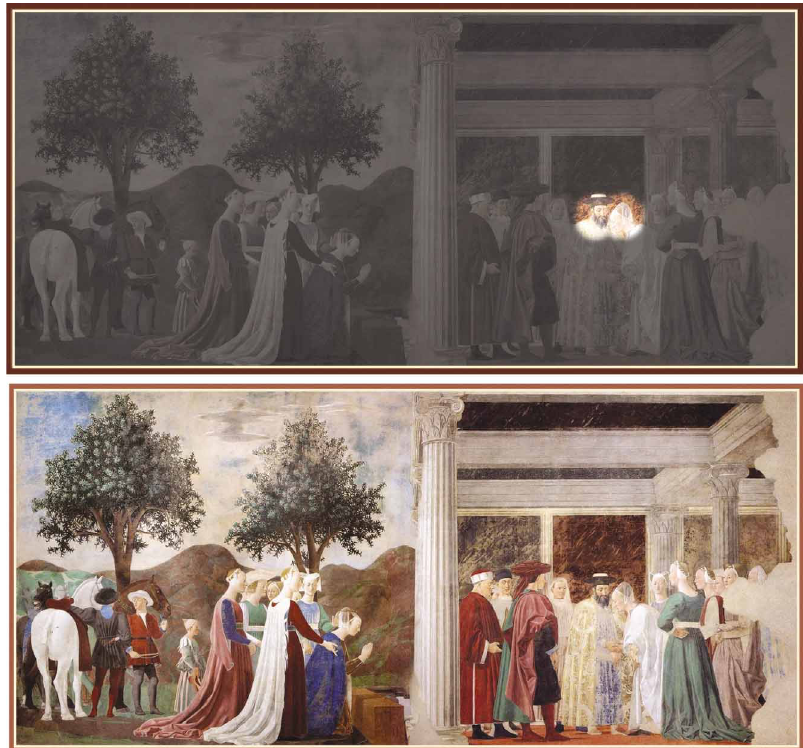
Figs. 3–4. Piero della Francesca. The Legend of the True Cross .